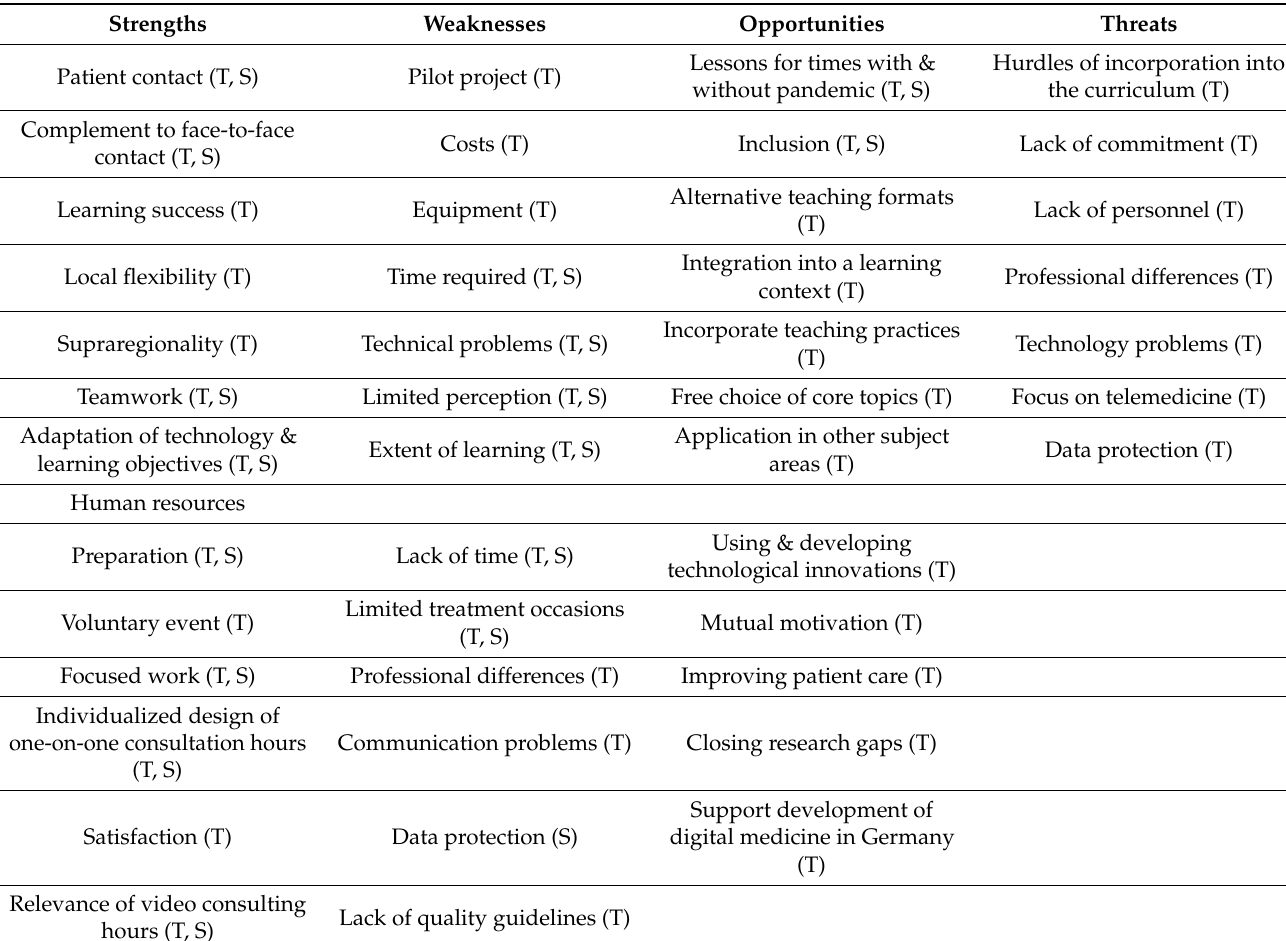
Table 3. Strengths, weaknesses, opportunities, and threats (S.W.O.T.) analysis on the use of the described seminar in medical